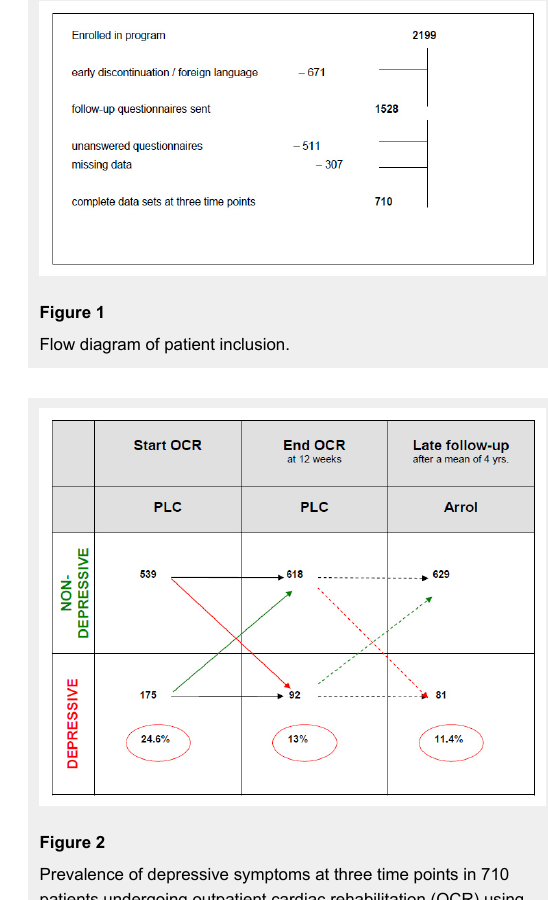
Prevalence of depressive symptoms at three time points in 710 patients undergoing outpatient cardiac rehabilitation (OCR) using two separate instruments of assessment (PLC and Aroll, see